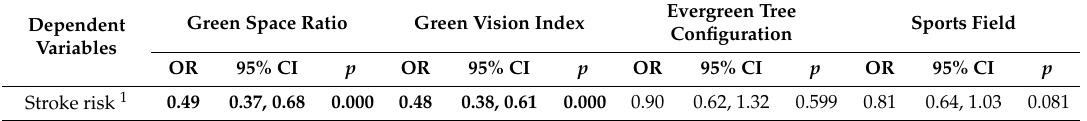
Table 4. Logistic regression analysis of the odds of stroke risk by characteristics of green space. Green Space Ratio Green Vision Dependent Variables